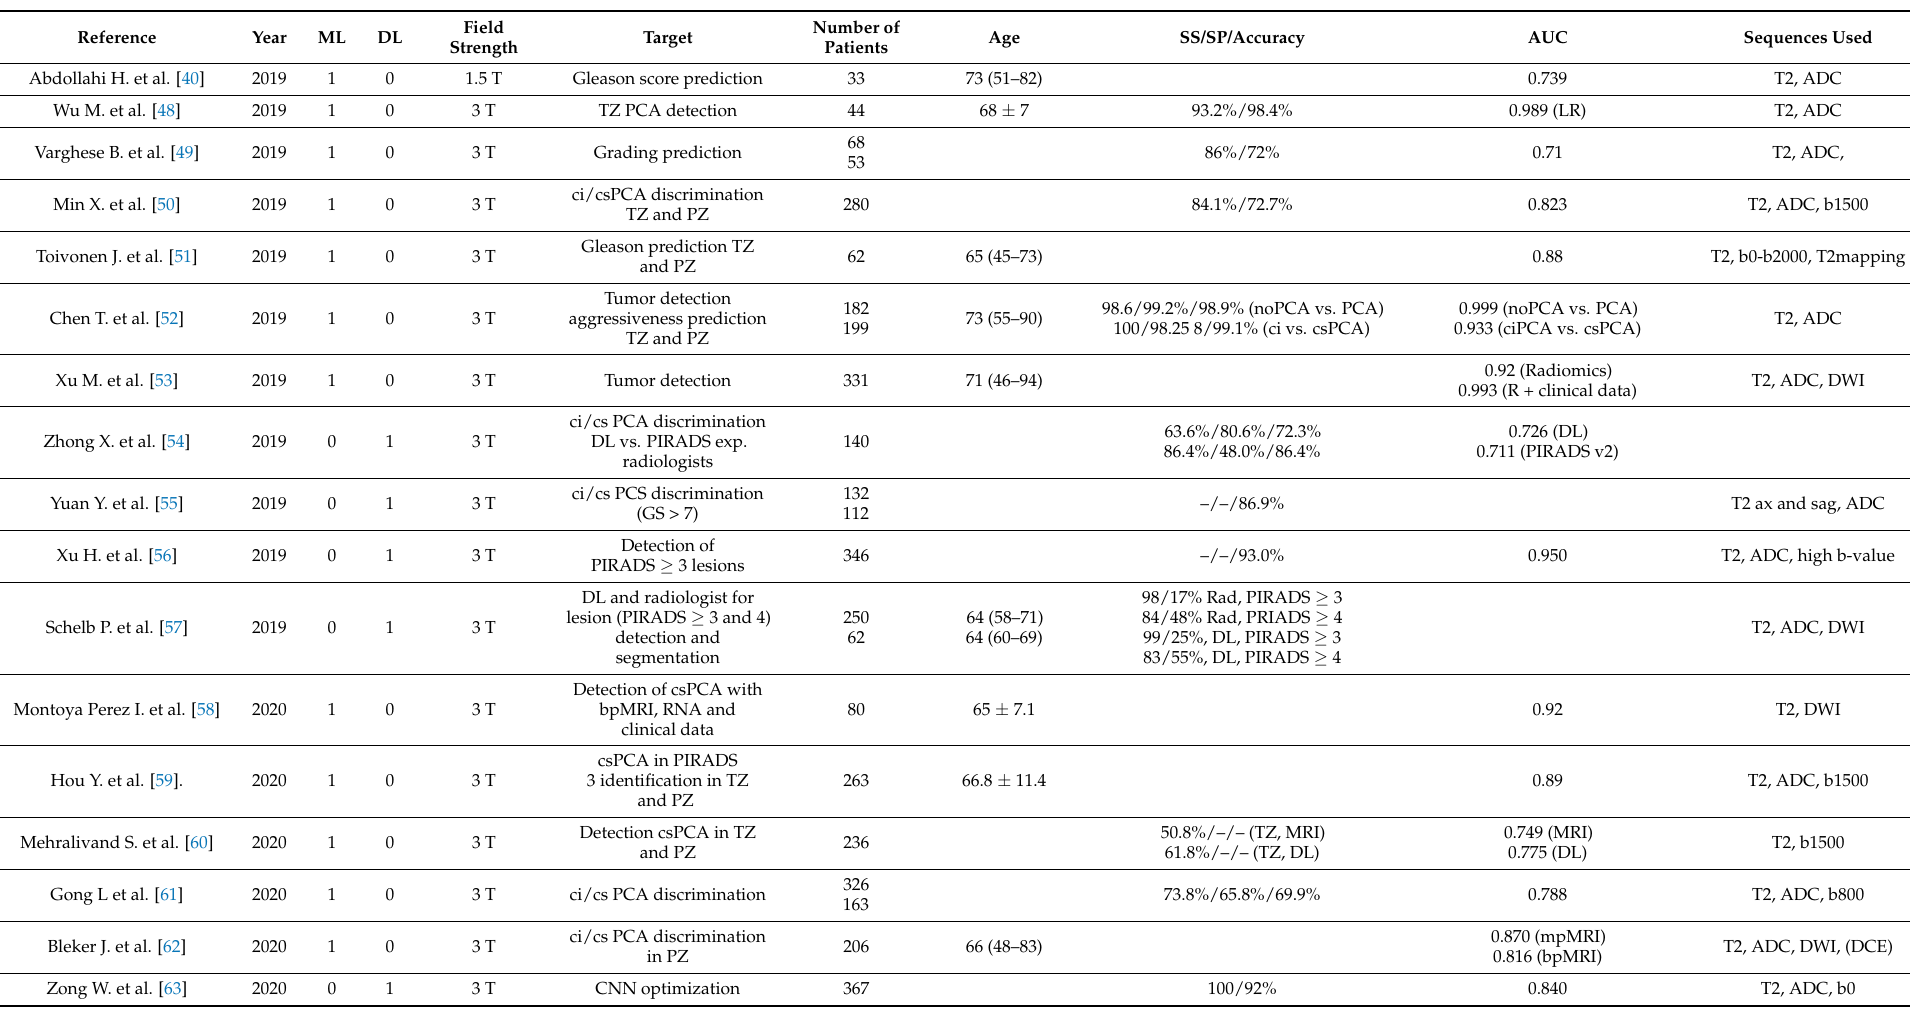
Table 1. List of include studies and relevant key